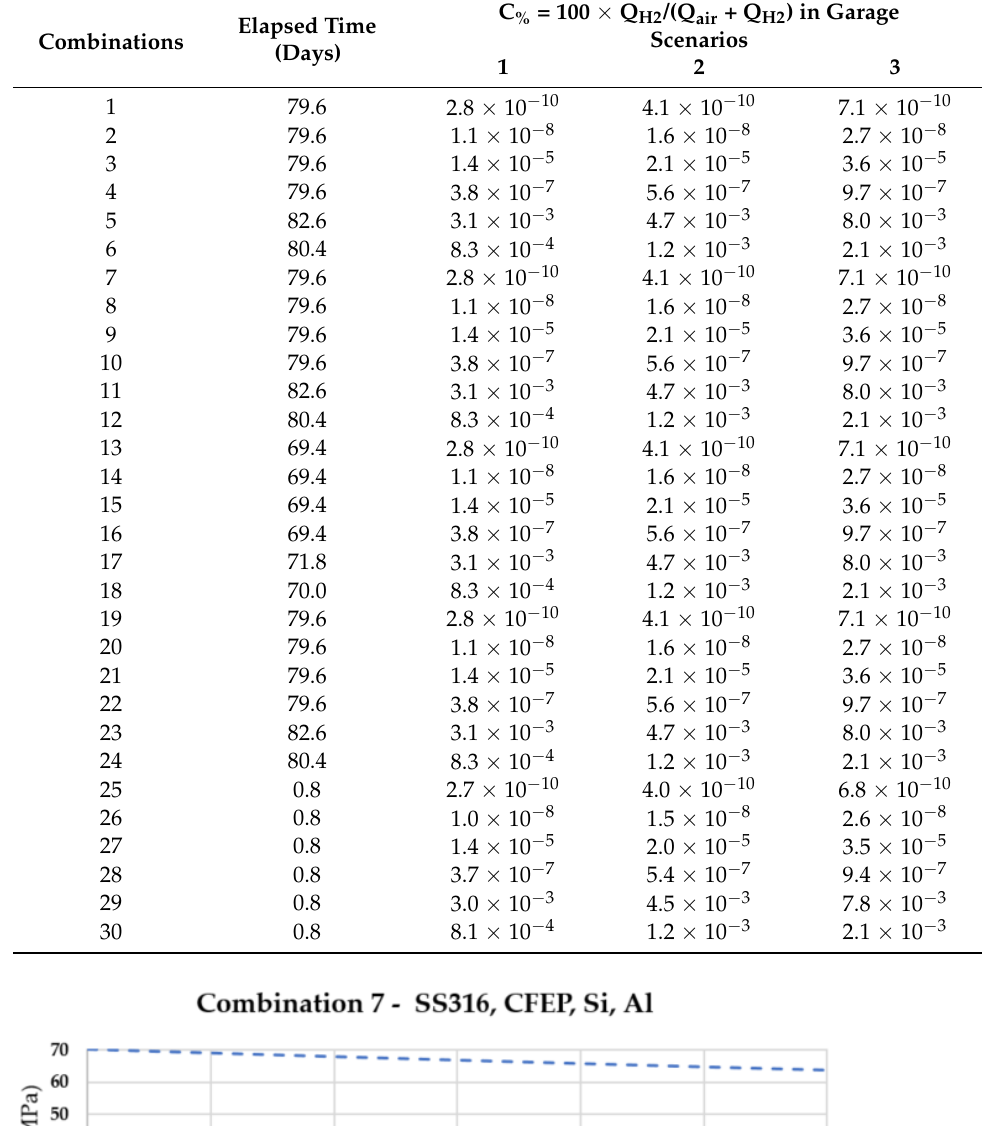
Table 5. Time to obtain 20 bar in the envelope tank and values of C % for the scenarios of Table 4.